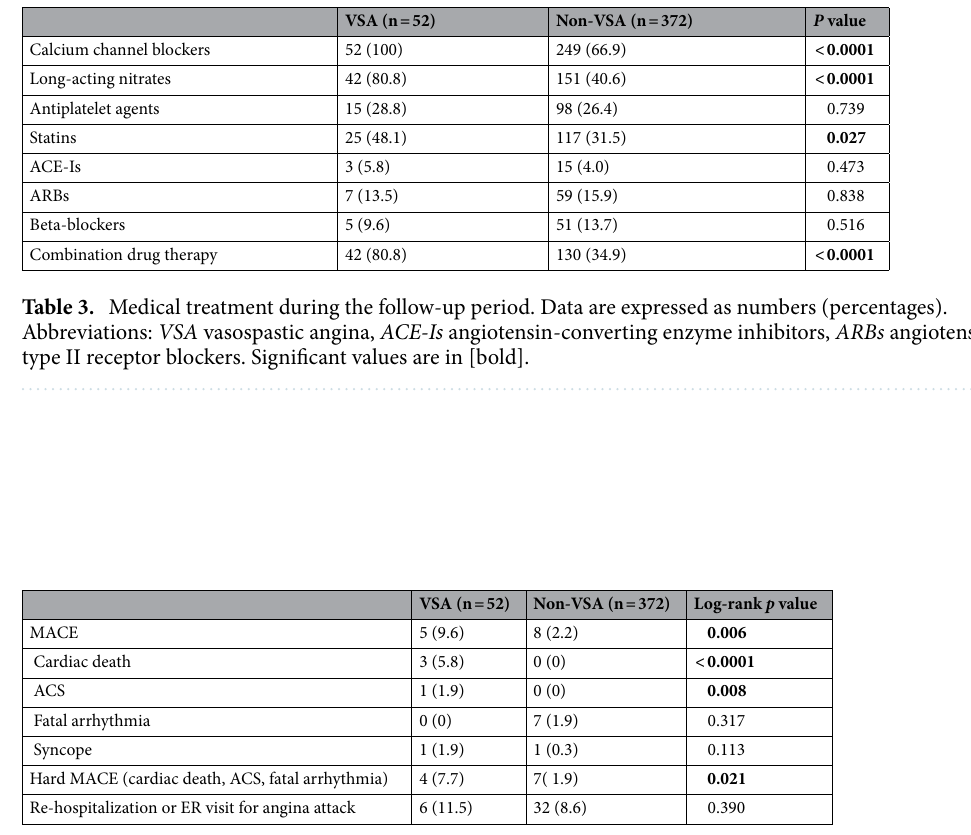
Table 4. Comparison of MACE in VSA and non-VSA groups by ergonovine provocation test. Data are expressed as numbers (percentages). Abbreviations: MACE major adverse cardiovascular event, VSA vasospastic angina, ACS acute coronary syndrome, ER emergency room. Significant values are in